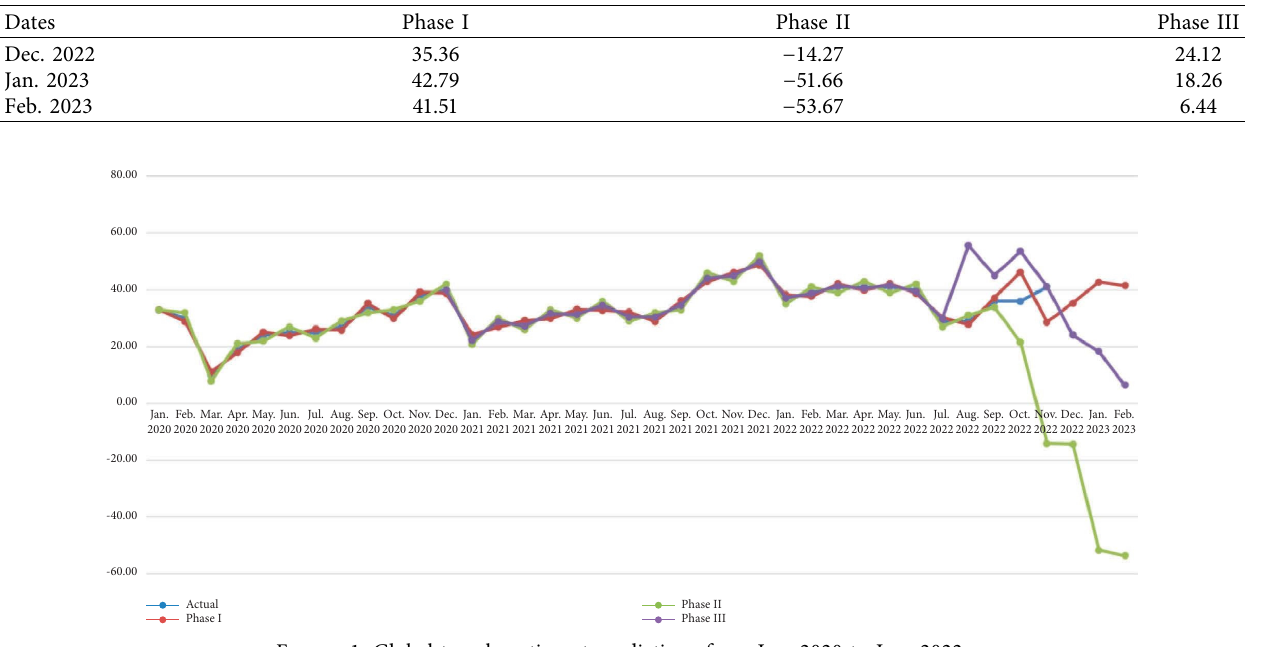
Figure 1: Global travel sentiment predictions from Jan. 2020 to Jun. 2022. Table 5: Prediction results of travel sentiment in